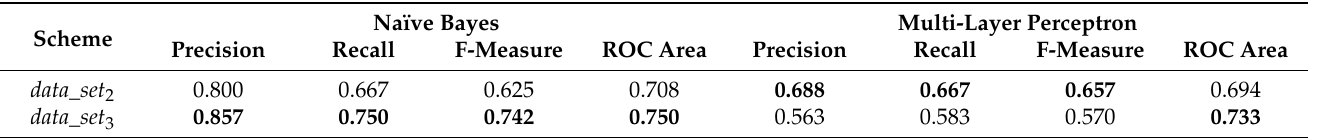
Table 14. Comparison of the two schemes with Naïve Bayes and Multi-layer